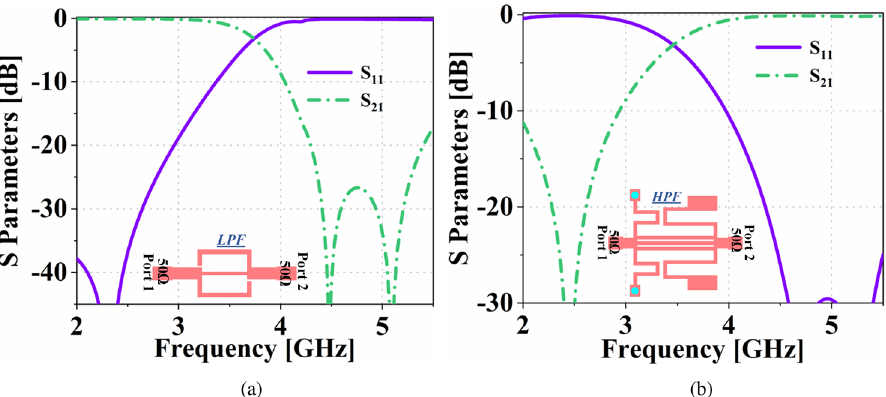
Figure 4. S-parameters of the the ( a ) LPF and ( b ) HPF, integrated into the FSMF of the proposed system.